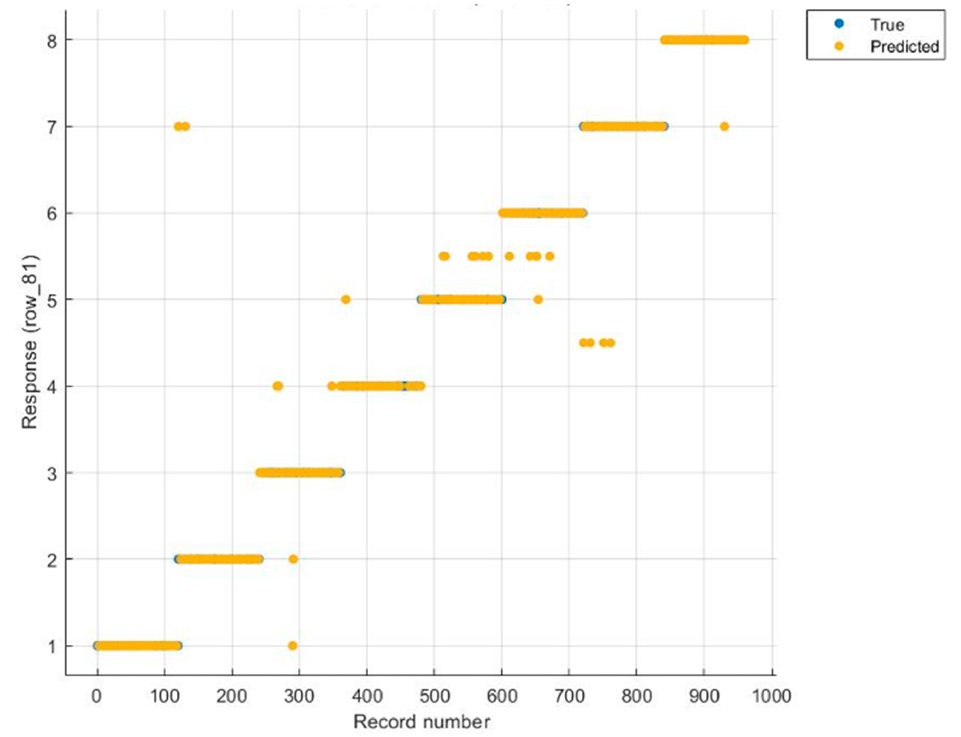
Figure 14. The classification of graph of Kernel Naïve Bayes model.